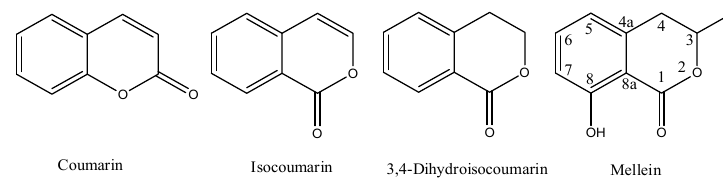
Figure 1. Structure of coumarin, isocoumarin, 3,4-dihydroisocoumarin and mellein.